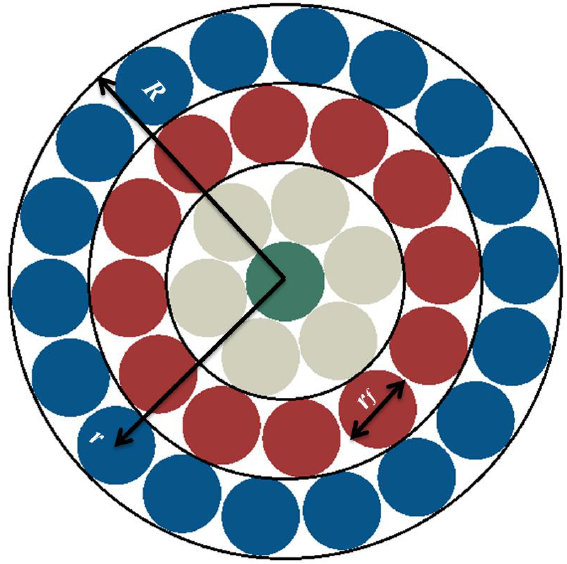
Figure 4. Ideal packing of circular fibers in yarns.